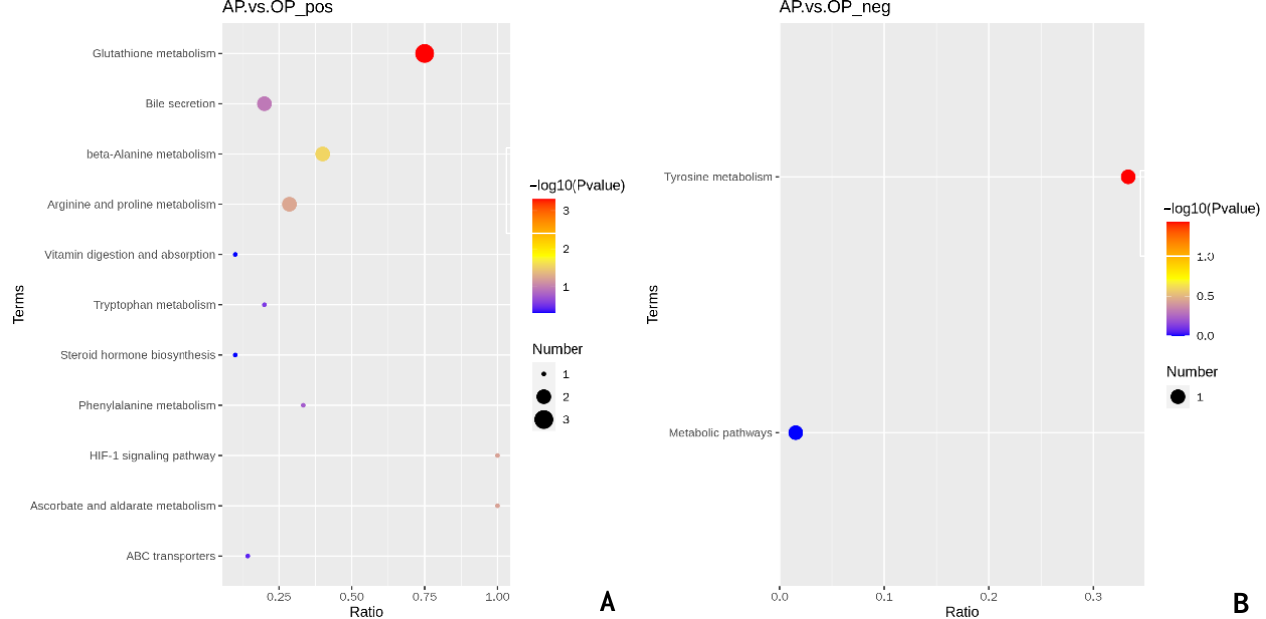
Figure 2. ( A ) KEGG metabolic pathway of AP vs. OP in positive ion mode; ( B ) KEGG metabolic pathway of AP vs. OP in negative ion mode. AP represents the group fed alfalfa (n = 5). OP represents the group fed oat (n = 5).